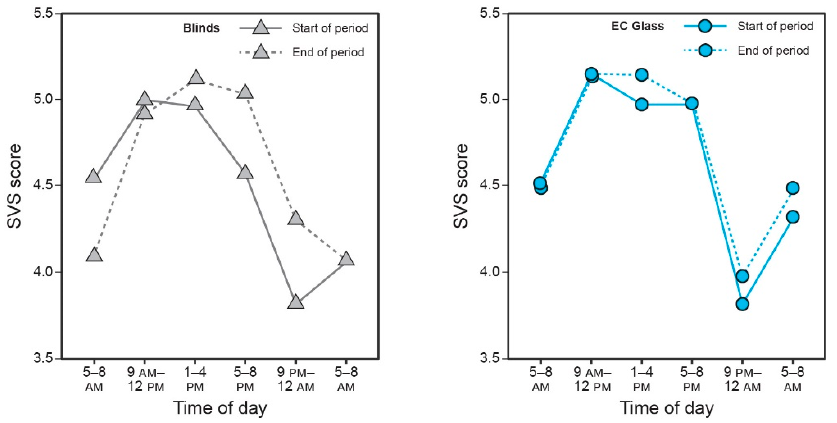
Figure 8. Composite SVS score across the day and following morning, at the start (Day 1) and end (Day 8) of the intervention weeks.